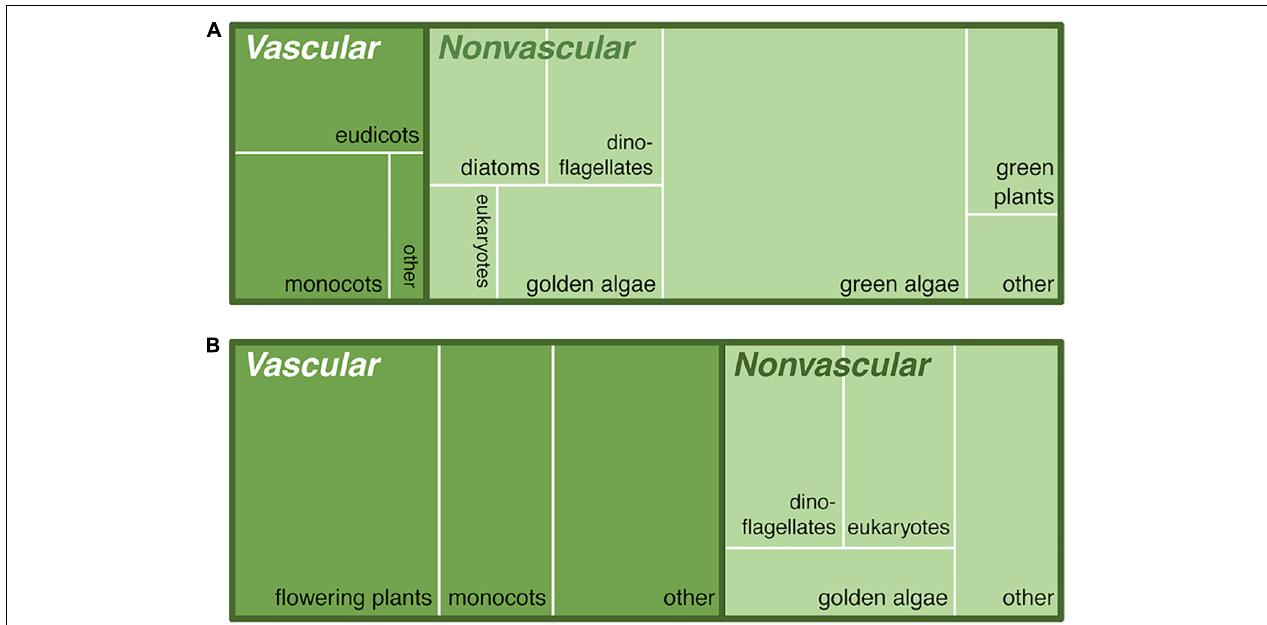
FIGURE 4 | Study taxa by NCBI taxonomic categories identified via ITS1 barcode sequencing in six lakes. These treemaps (Shneiderman, 1992) are proportional representations of vascular plants (darker green) and non-vascular plants/algae (lighter green) by (A) numbers of taxa identified vs. (B) read abundance. Note the variation in dominance in subcategories like “eukaryotes” (generally photosynthetic protists) and “flowering plants” (largely aquatics in the Nymphales and Ceratophyllales, predating the monocot/dicot split). The “green plants” in the non-vascular category are in the Zygnematophyceae, or conjugating algae, a close outgroup to the land